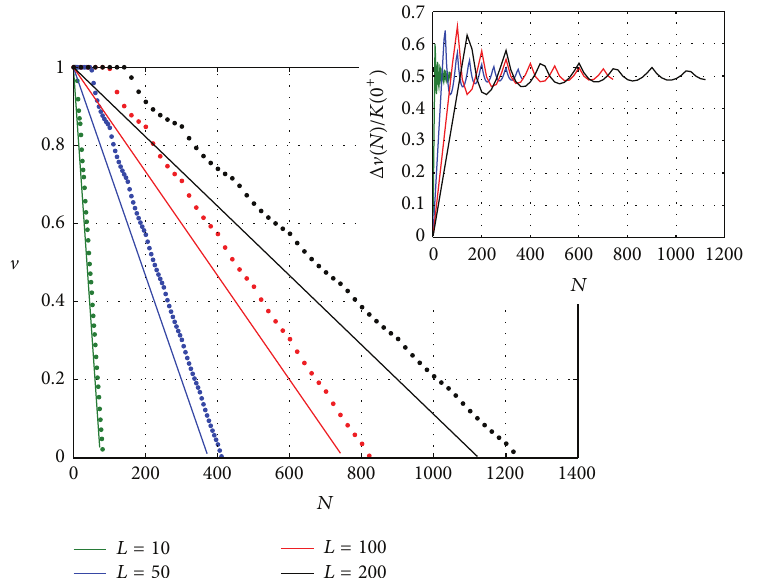
Figure 4: Speed diagrams (20) (discrete model, dots) and (21) (continuous model, solid lines) obtained, for different values of 𝐿 , with V d = 1 , 𝐾(𝑧) = (1/5)(1 − 𝑧 2 ) . The graph in the upper-right box shows the convergence to 0.5 of the quantity Δ V (𝑁)/𝐾(0 + ) for 𝑁 → ∞